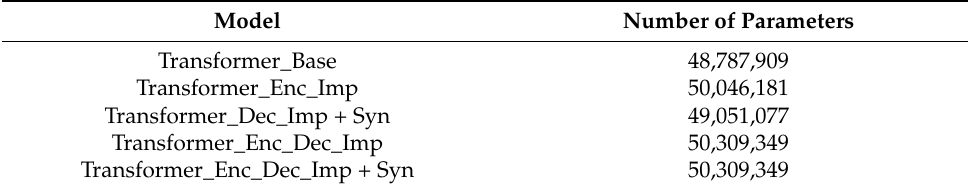
Table 2. The number of parameters for each six-layer